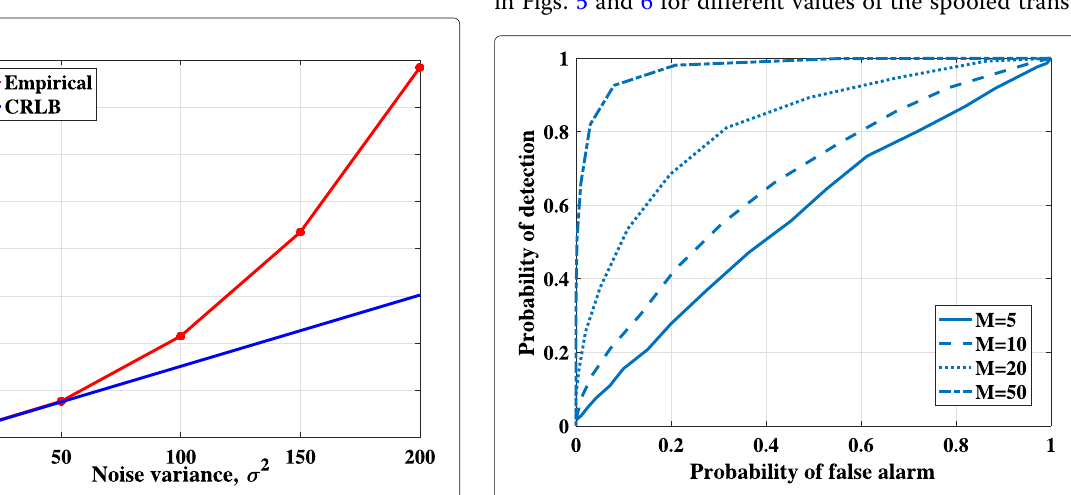
Fig. 3 Estimation variance for θ as function of the noise power σ 2 , compared to the CRLB